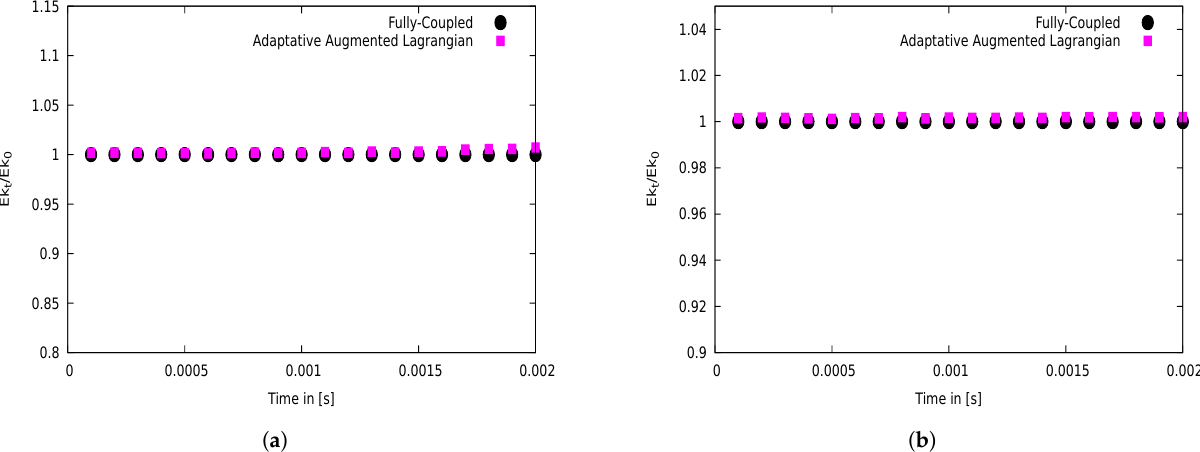
Figure 5. Time evolution of normalized kinetic energy for the high density ratio periodic Liquid sheet. Results obtained by different numerical methods, where ( a ) density ratio is 1000 and ( b ) density ratio is